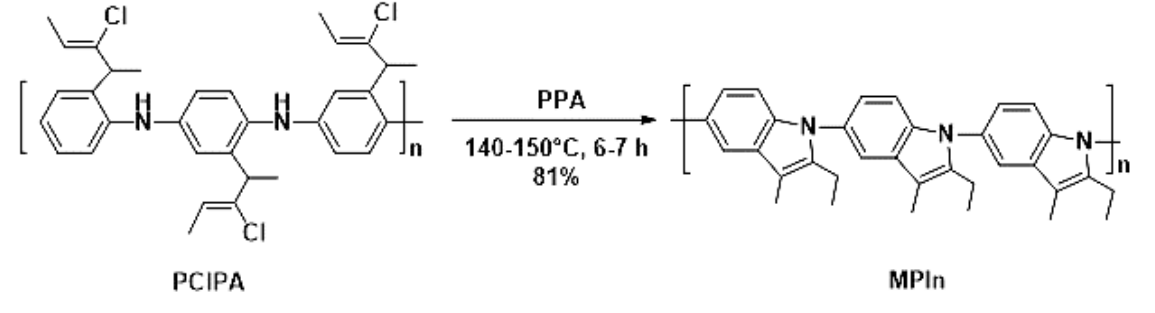
Figure 1. Synthesis of MPIn.